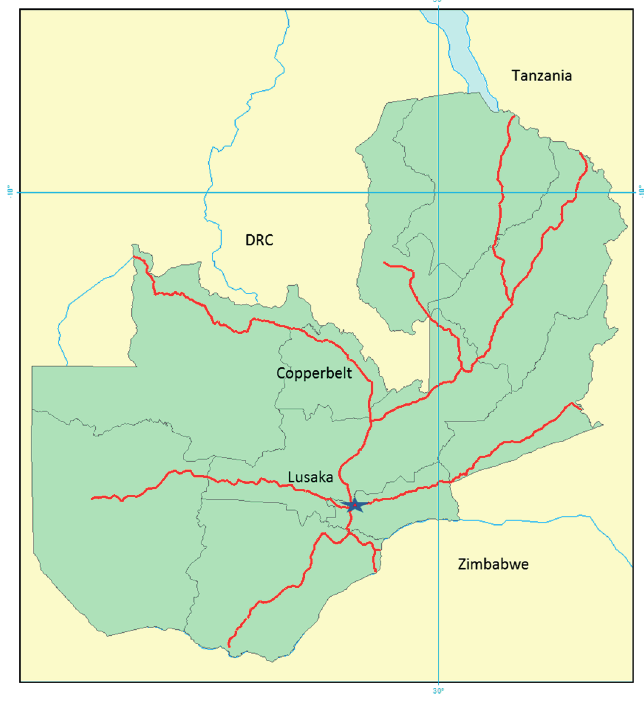
Figure 1. Zambia’s “Line of